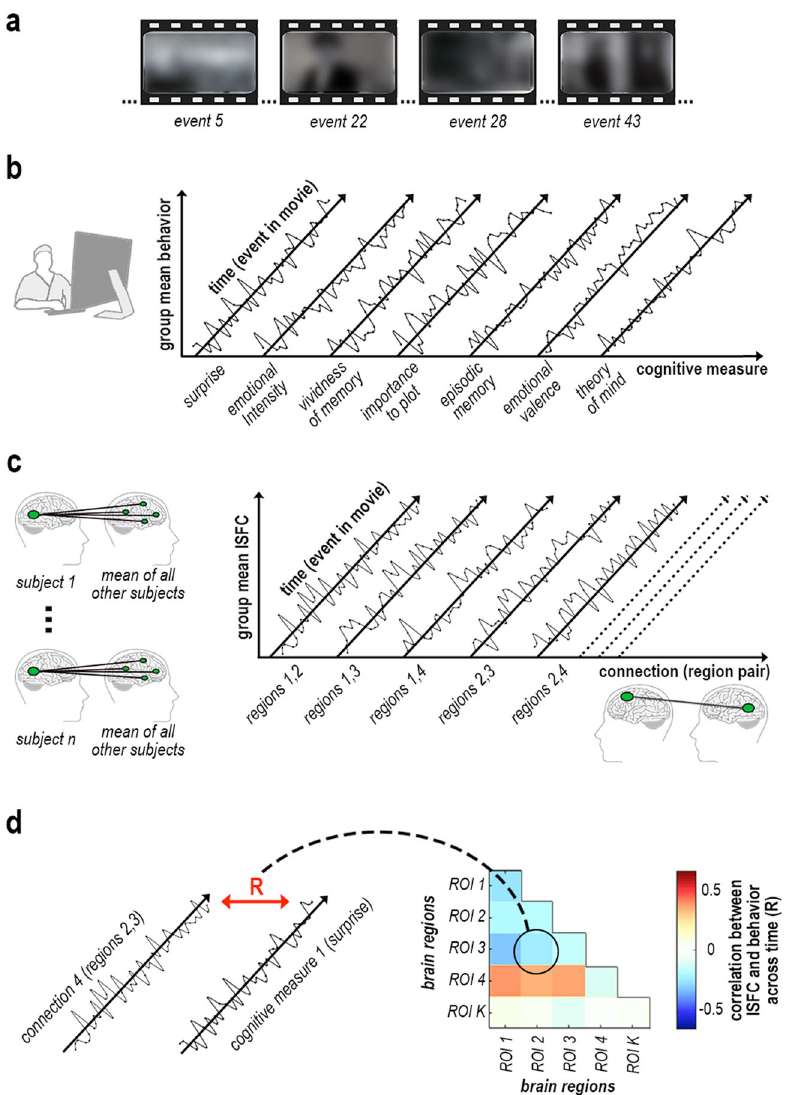
Fig. 1 State- fl uctuation pattern analysis (SFPA) of naturalistic narrative processing. Illustration of methodology, presenting hypothetical sample stimuli and data. a A 23-min-long excerpt of Sherlock (BBC, 2010) was viewed during either fMRI or web-based participation. Retrospective behavioral sampling was performed on 49 movie events. b Following web-based viewing, each event was probed verbally in a questionnaire, retrospectively measuring the fl uctuation in seven cognitive states throughout the movie. c ISFC corresponding to each movie event ±7 TR was measured by correlating the time-window fMRI signal between every region in each participant and every other region in all other participants, measuring the fl uctuation in coactivation throughout the movie. d Temporal patterns of cognitive states and ISFC were tested for correlation across movie